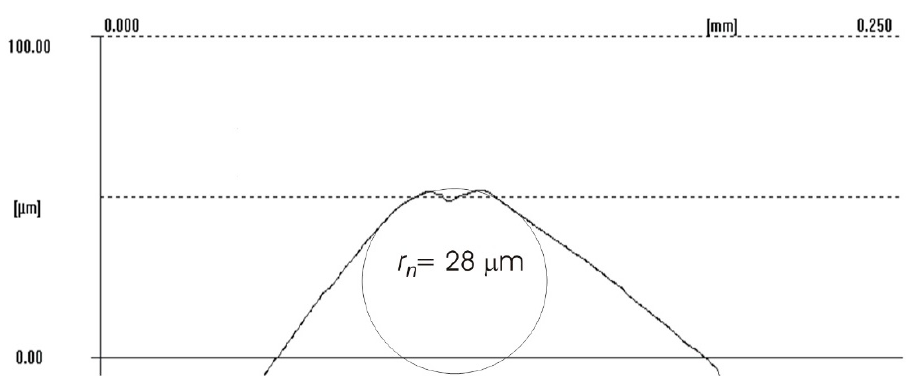
Figure 21. Cutting edge radius r n of the worn cutting insert after longitudinal turning with coolant (23 HRC).